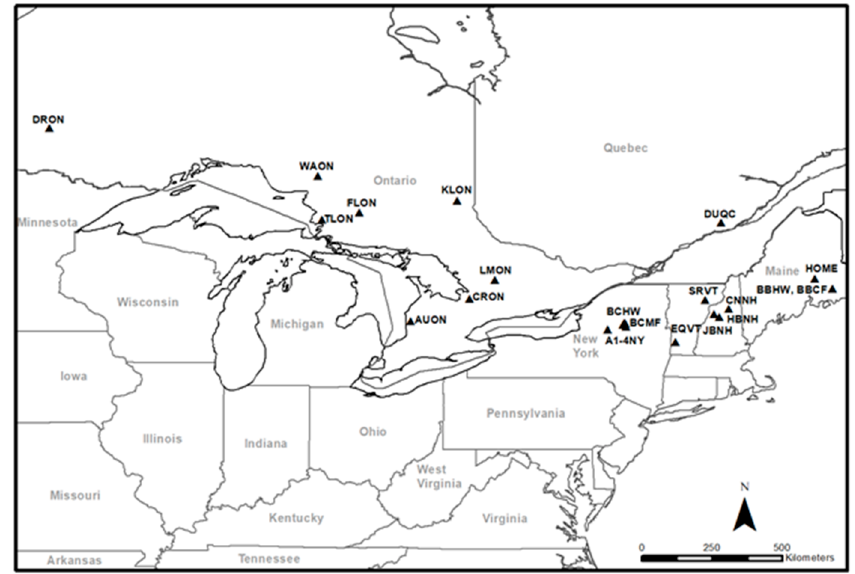
Figure 1. Location of soil resampling sites in Eastern Canada and the Northeastern United States.